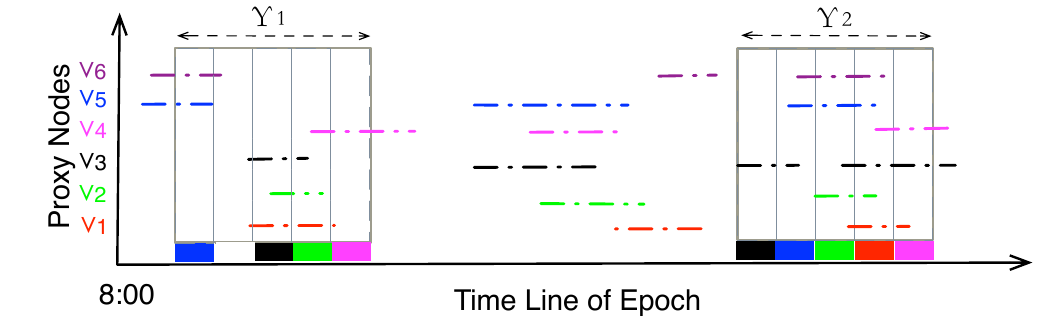
Figure 5. Mapping the Proxy node Time Slot Allocation ( P T SA ) problem into the problem of maximal coverage of line